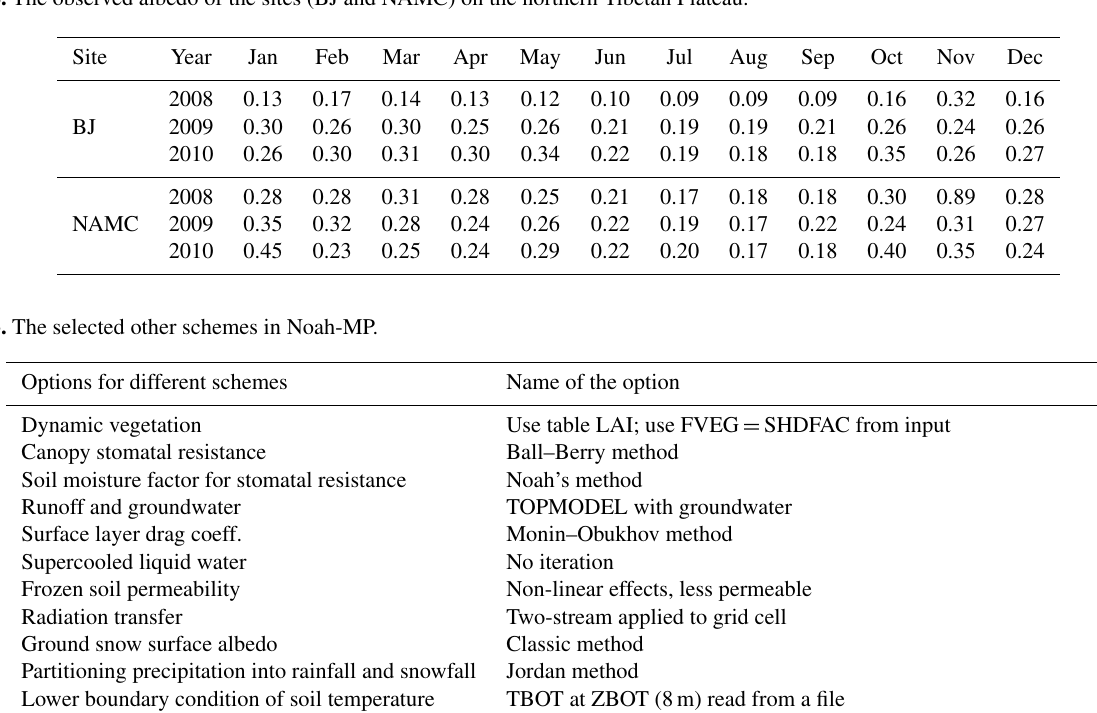
Table 2. The observed albedo of the sites (BJ and NAMC) on the northern Tibetan Plateau. Site